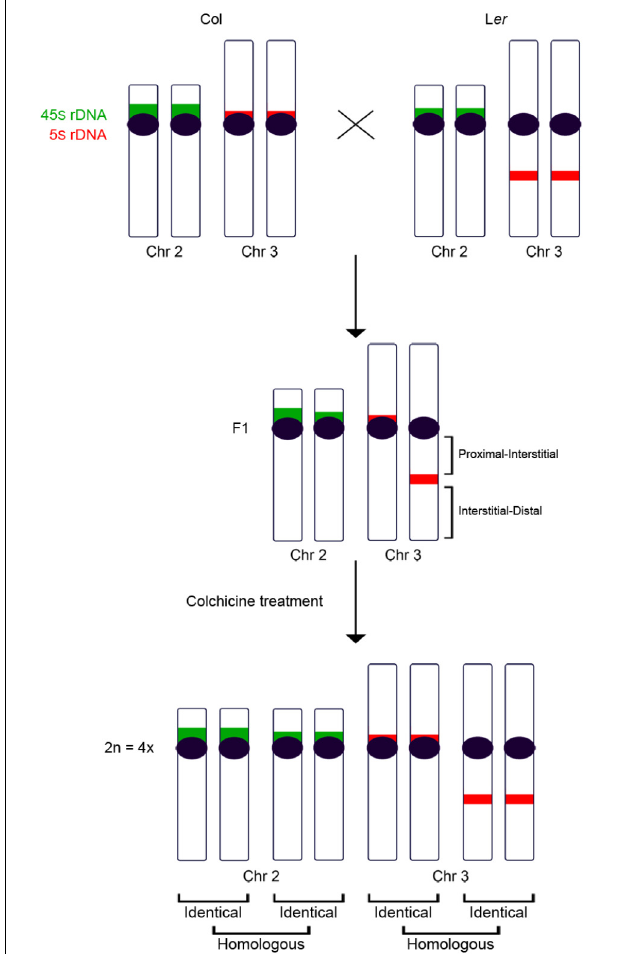
FIGURE 1 | Ideogram of chromosomes 2 and 3 in Col, L er and in the hybrid progeny obtained from the cross between both accessions before and after the chromosome duplication. Col and L er chromosomes 2 and 3 can be distinguished after applying FISH with 5S (red) and 45S (green) rDNA probes. These differences allow the identification of the parental origin of each chromosome in the hybrid, before and after the colchicine treatment. In the tetraploid hybrid, each chromosome is accompanied by one identical chromosome and two homologous chromosomes.